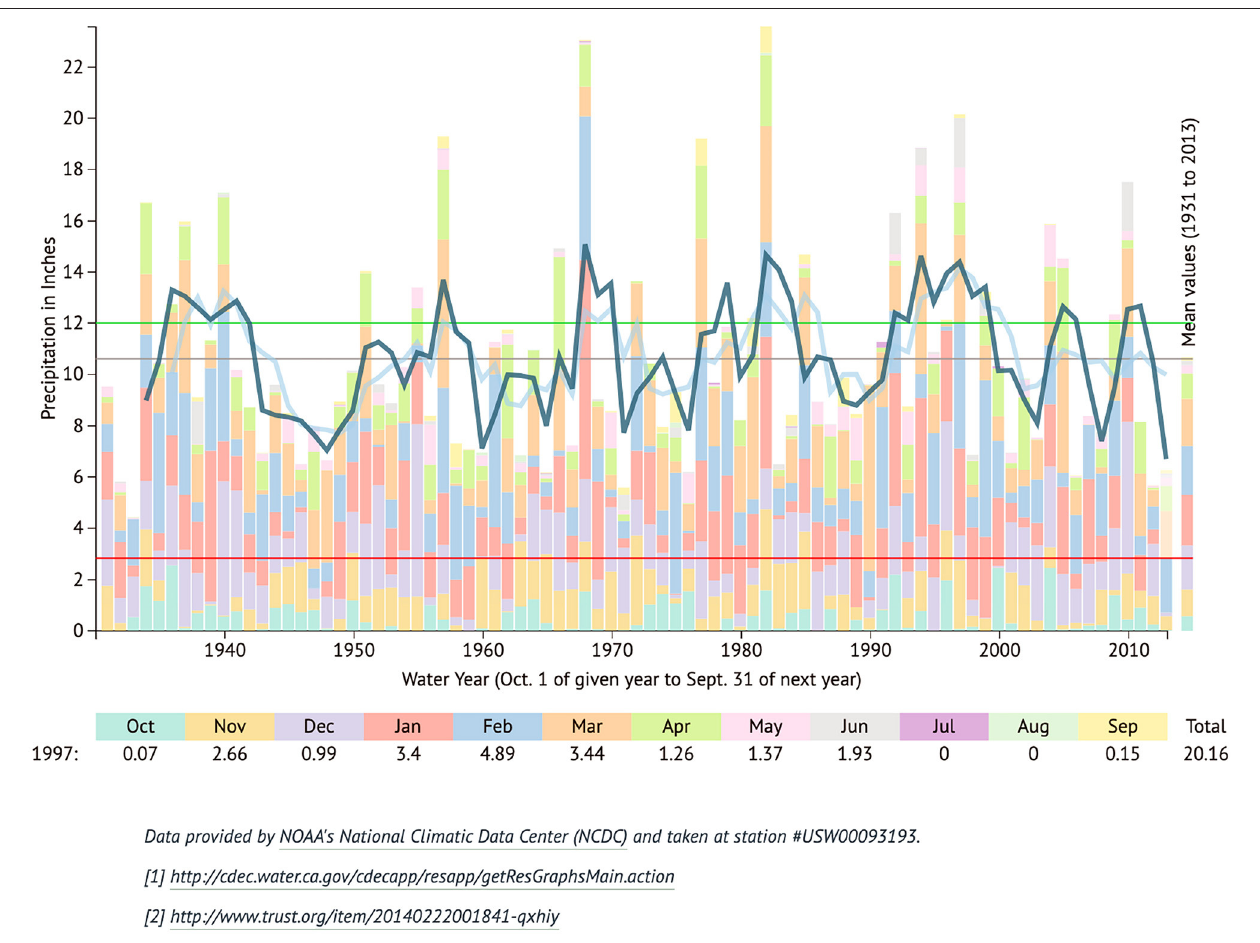
FIGURE 3 | Yearly precipitation segmented by month in Fresno, CA (Polis, 2014, March 7). Red line, total precipitation through Feb. 31 (2.83 ′′ ); green line, typical rainfall value through Feb; dark blue line, 3 year moving average; light blue line, 5 year moving average. Photo courtesy of C. Polis,